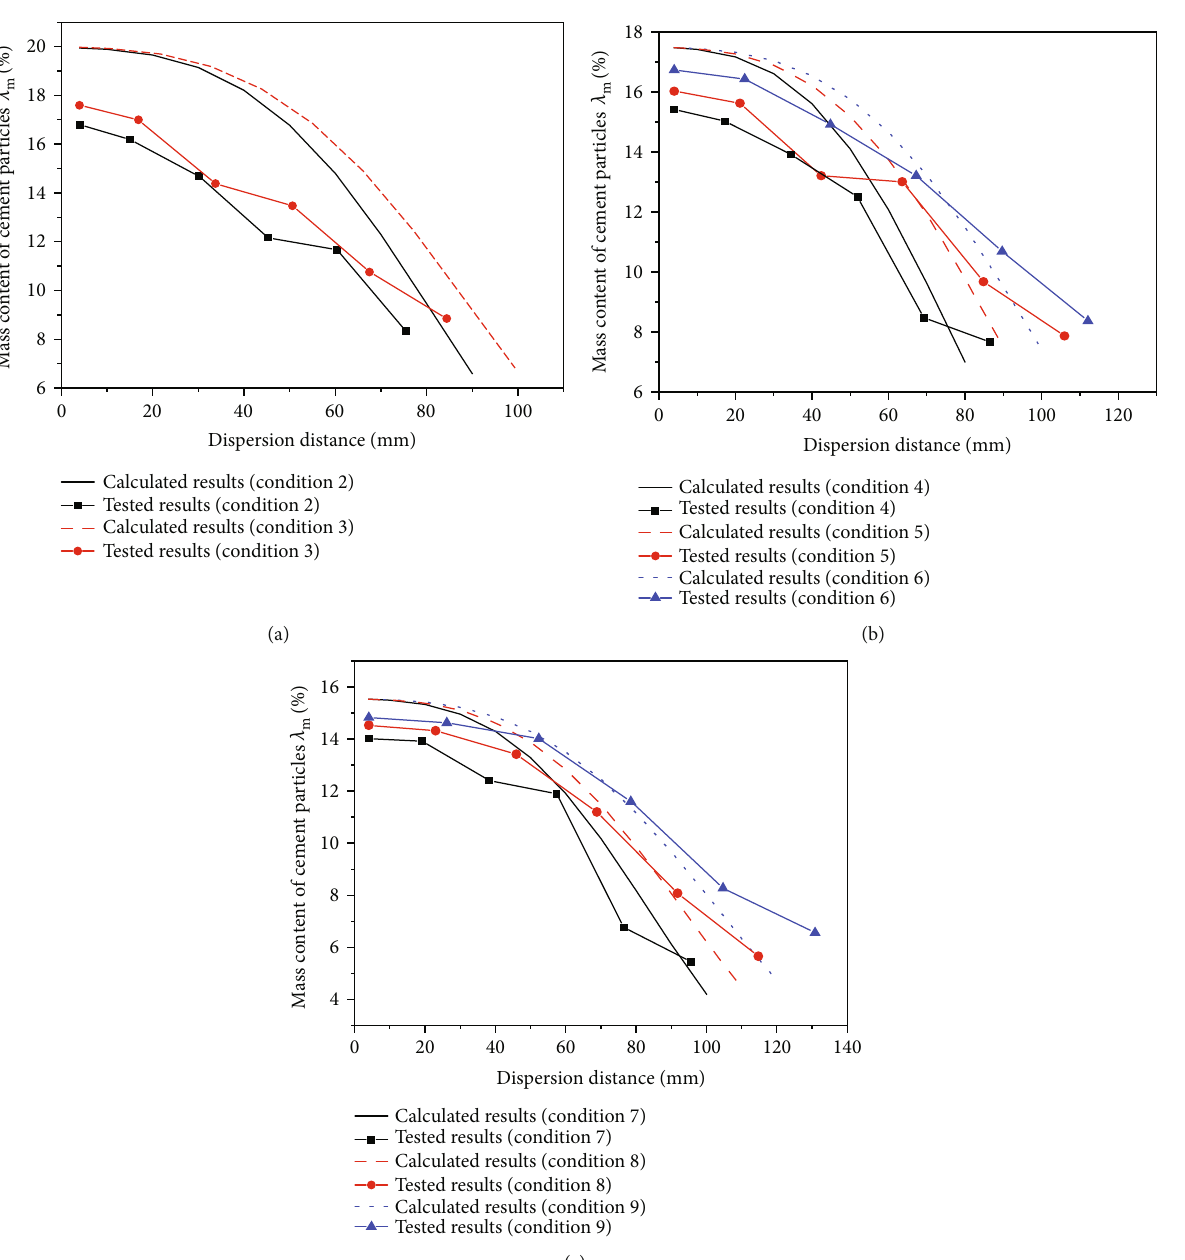
W / C = 0 : 8 ; (b) W / m of grouting mass: (a)